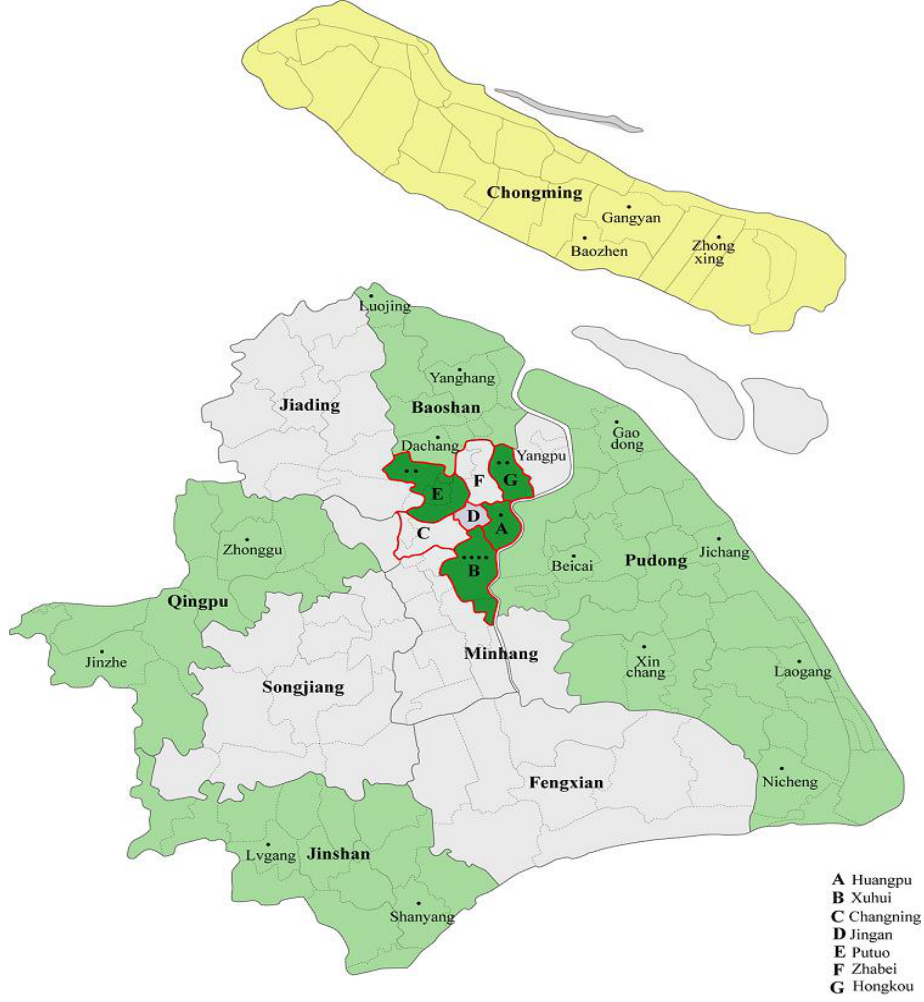
Figure 1. Multi-stage cluster random sampling of the Shanghai Food Consumption Survey.